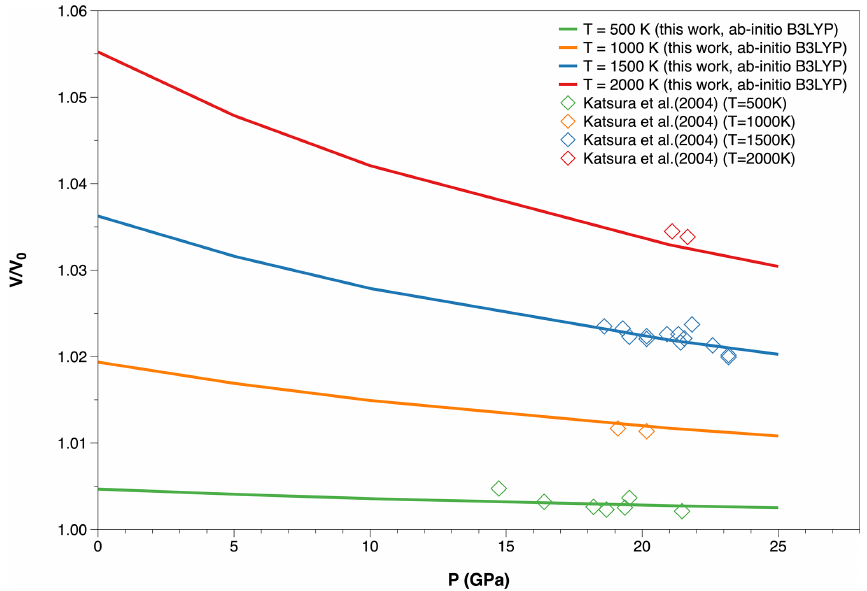
Figure 6. Ab initio volume thermal expansion ( V/V 0 ) of Mg 2 SiO 4 ringwoodite along different isotherms ( T = 500, 1000, 1500 and 2000K). Experimental data are taken from Katsura et al. (2004).